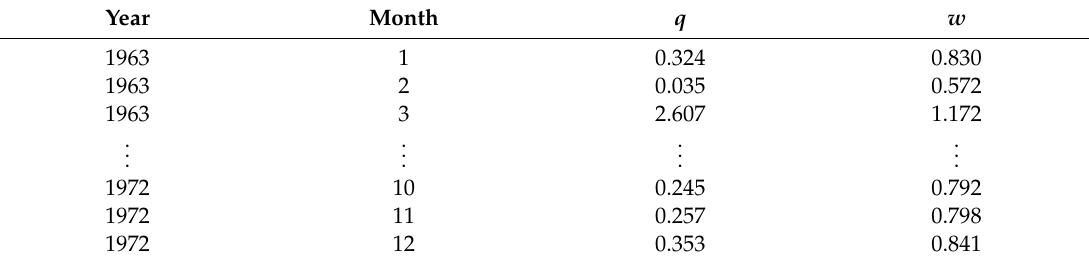
Figure 5. The P–P plot of the dimensionless monthly streamflow data after normalization.